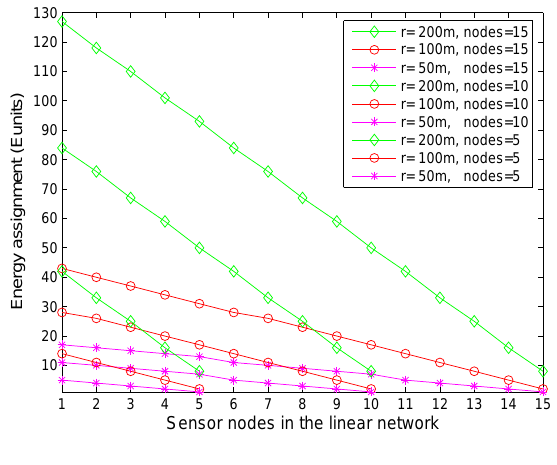
Figure 16. Energy assignment with different